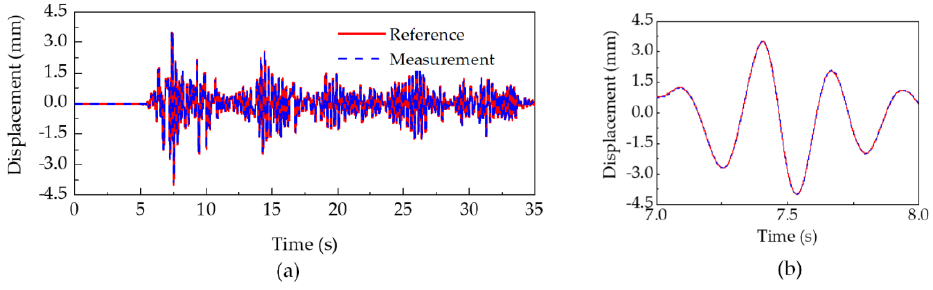
Figure 11. Displacement time histories of the first floor for Case 1. ( a ) Overview; ( b ) Enlarged view.